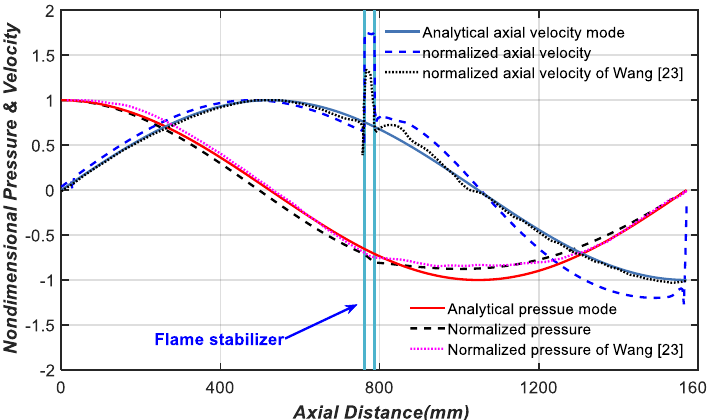
Figure 11. Comparison of the simulated pressure and velocity along the centerline with the analytical prediction results.